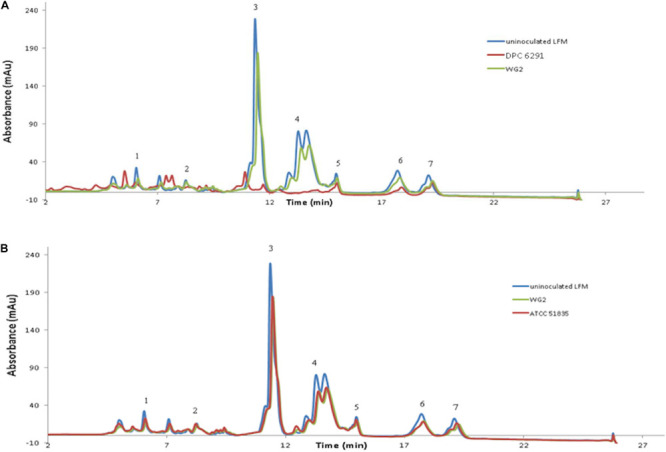
RP-HPLC profiles for the following six strains (A) DPC6291, (B) ATCC51835 analyzed along with controls uninoculated LFM and Lactococcus lactis subsp. cremoris Wg2. Peaks representing fraction of casein and whey proteins (1) K-casein, (2) αs2-casein (3) αs1-casein (4) β-casein (5) α-lactalbumin (6) β-lactoglobulin a (7) β-lactoglobulin b.